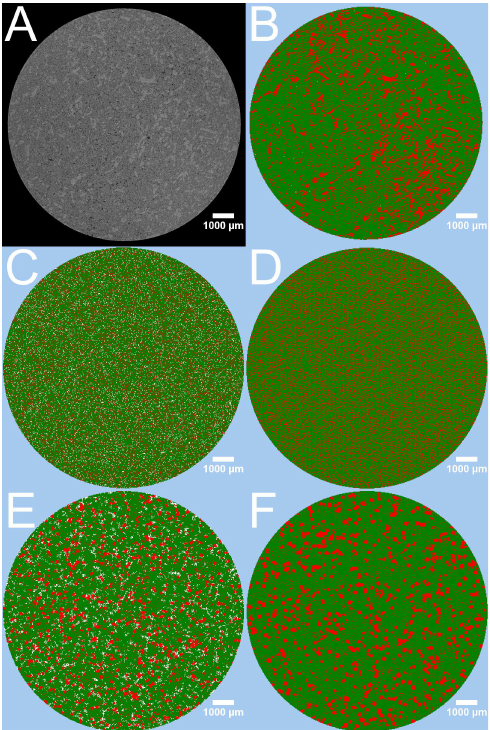
Figure 3. Different cross-sections of tablet 3 of batch T25E75. Theophylline is represented as light grey or red, ethylcellulose as dark grey or green, and air as black or white, respectively. ( A ) Cross-section 88 of the binned X µ CT image. ( B ) Cross-section 88 of the virtual tablet created by the PAC-module using the final processed X µ CT image of the pathway B1. ( C ) Cross-section of the virtual tablet obtained by distributing the target masses of the compounds. ( D ) Cross-section of the virtual tablet obtained by distributing the both compounds in the determined ratio until the interparticular porosity is 0. ( E ) Cross-section of the virtual tablet obtained by distributing seeds and growing them to the target masses of the compounds. ( F ) Cross-section of the virtual tablet obtained by distributing seeds and growing them in the determined ratio until the interparticular porosity is